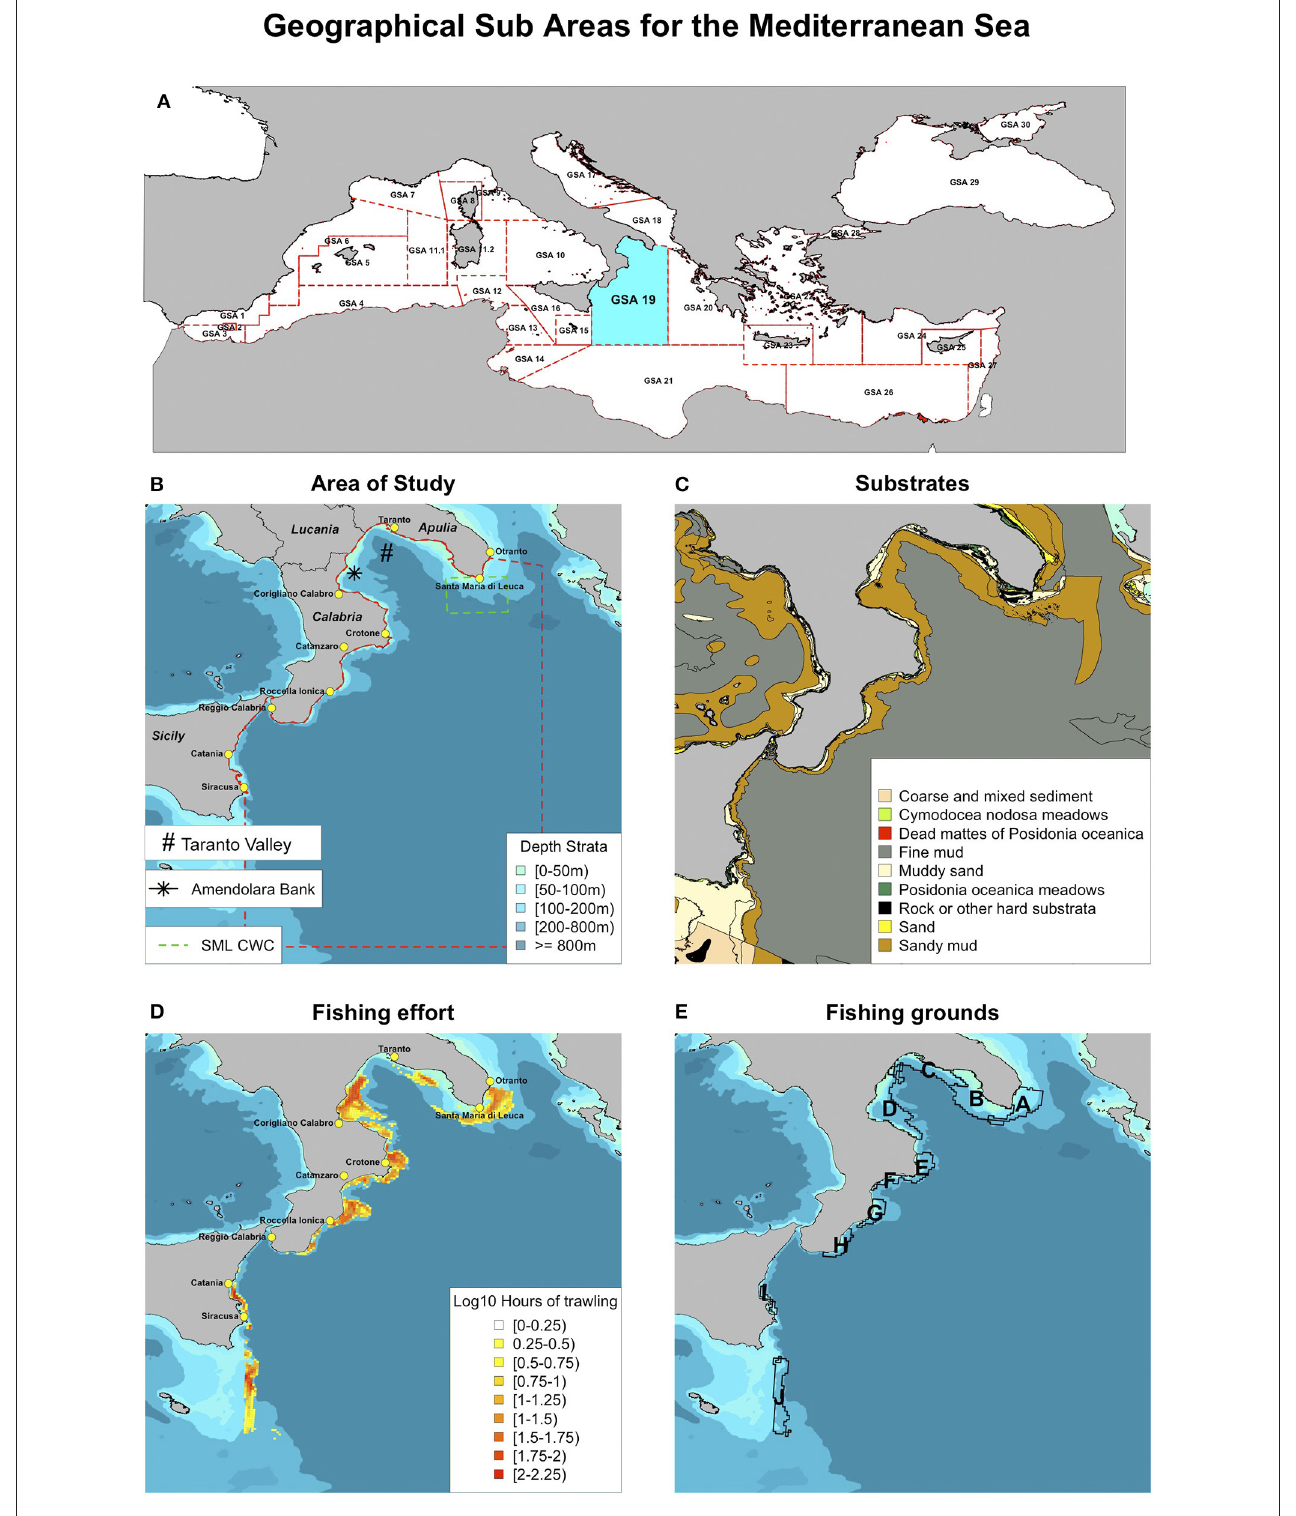
FIGURE 1 | (A) The fisheries management set at the scale of Geographical Sub-Areas in the Mediterranean Sea; (B) Study area (GSA 19) with the main bathymetric strata and the harbors; SML CWC stands for Santa Maria di Leuca cold-water coral; (C) sea bottom substrates as derived from the European Marine Observation Data Network (EMODnet) Seabed Habitats project (www.emodnet-seabedhabitats.eu/); (D) yearly trawling effort (mean for 2008–2015) for vessel monitoring system (VMS)-equipped vessels with a length-over-all (LOA) > 15m with respect to a 3 × 3 km grid; (E) fishing grounds returned by the constrained clustering analysis.